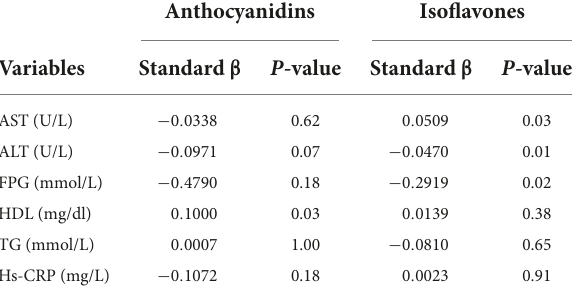
TABLE 4 Adjusted linear regression of liver and metabolism markers and anthocyanidin or isoflavone intake, weighted.